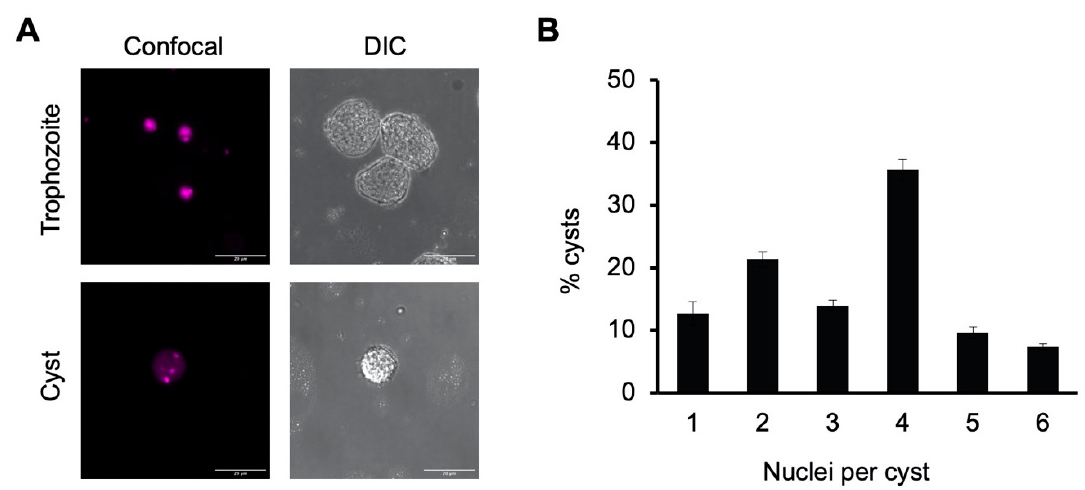
Figure 1. E. histolytica cysts are multinucleate. ( A ) Representative image of E. histolytica trophozoites (top) and sarkosyl- treated cysts (bottom) stained with propidium iodide for microscopic visualization of nuclei. Confocal images (left) and their corresponding DIC images (right) are shown with 20 µ m scale bars. ( B ) Number of nuclei per cyst. Cysts from three biological replicates were stained with propidium iodide, and nuclei in 100 cysts from each culture were manually counted. Results shown are the mean ± standard deviation for three independent biological replicates.